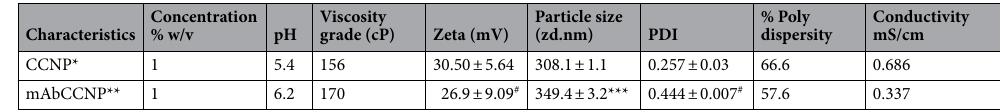
Table 2. Physical characterization of nanoparticles. *CCNP: Cisplatin loaded chitosan nanoparticles; **mAbCCNP: Rituximab surface linked cisplatin loaded chitosan nanoparticles; PDI: Poly dispersity index; cP: Centipoise; z.d.nm: Zeta average particle size in nano meter; mV: Milli volt; mS/cm milli Siemens per centimetre. ***Extremely significant at p < 0.001when compared to CCNP (mean of n = 3 with standard deviation); # Non significant at p > 0.05 when compared to CCNP (mean of n = 3 with standard deviation).